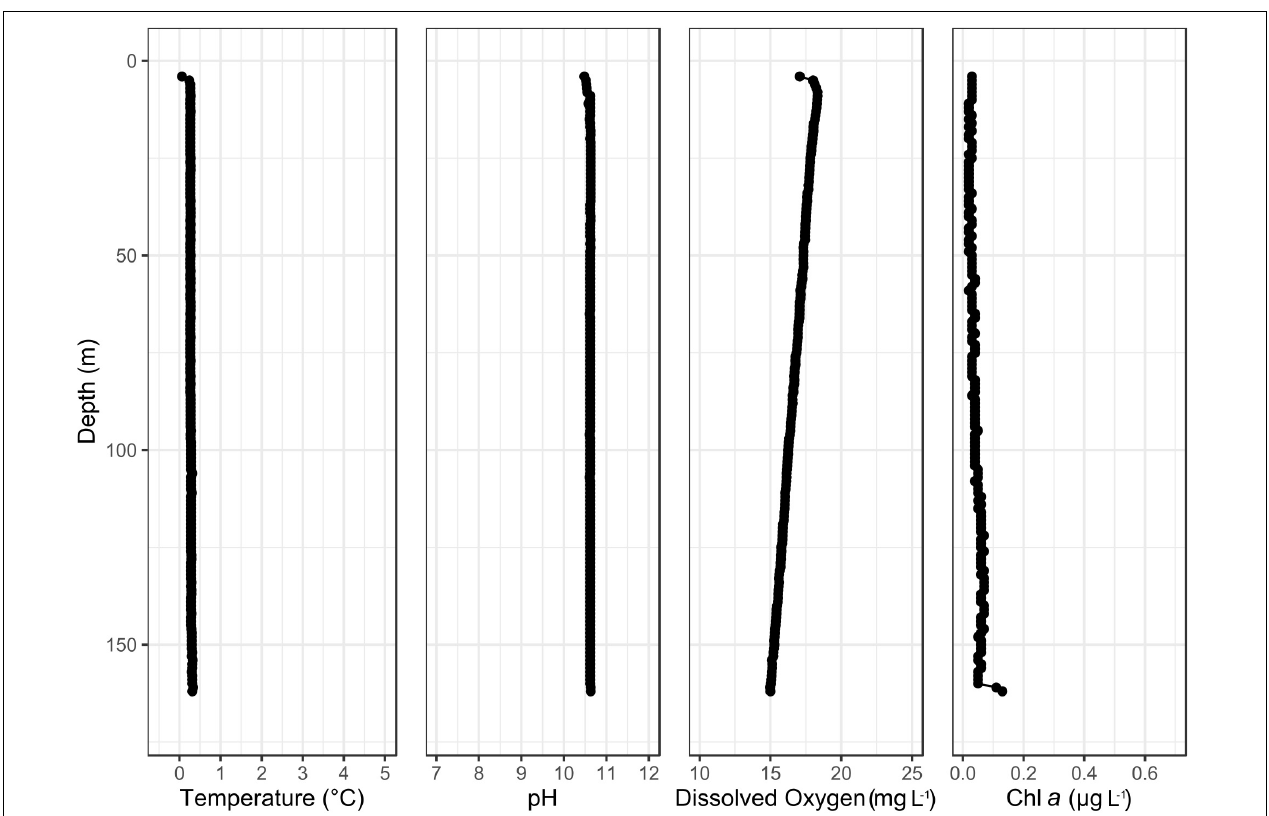
FIGURE 3 | Temperature, pH, dissolved oxygen and chlorophyll- a water column profile of the northern basin of Lake Untersee.